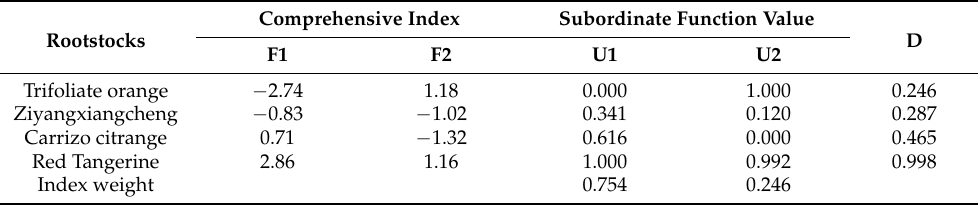
Table 7. Comprehensive index (F), subordinate function (U), and integrated assessment (D) values for four citrus rootstock seedlings under excess B stress